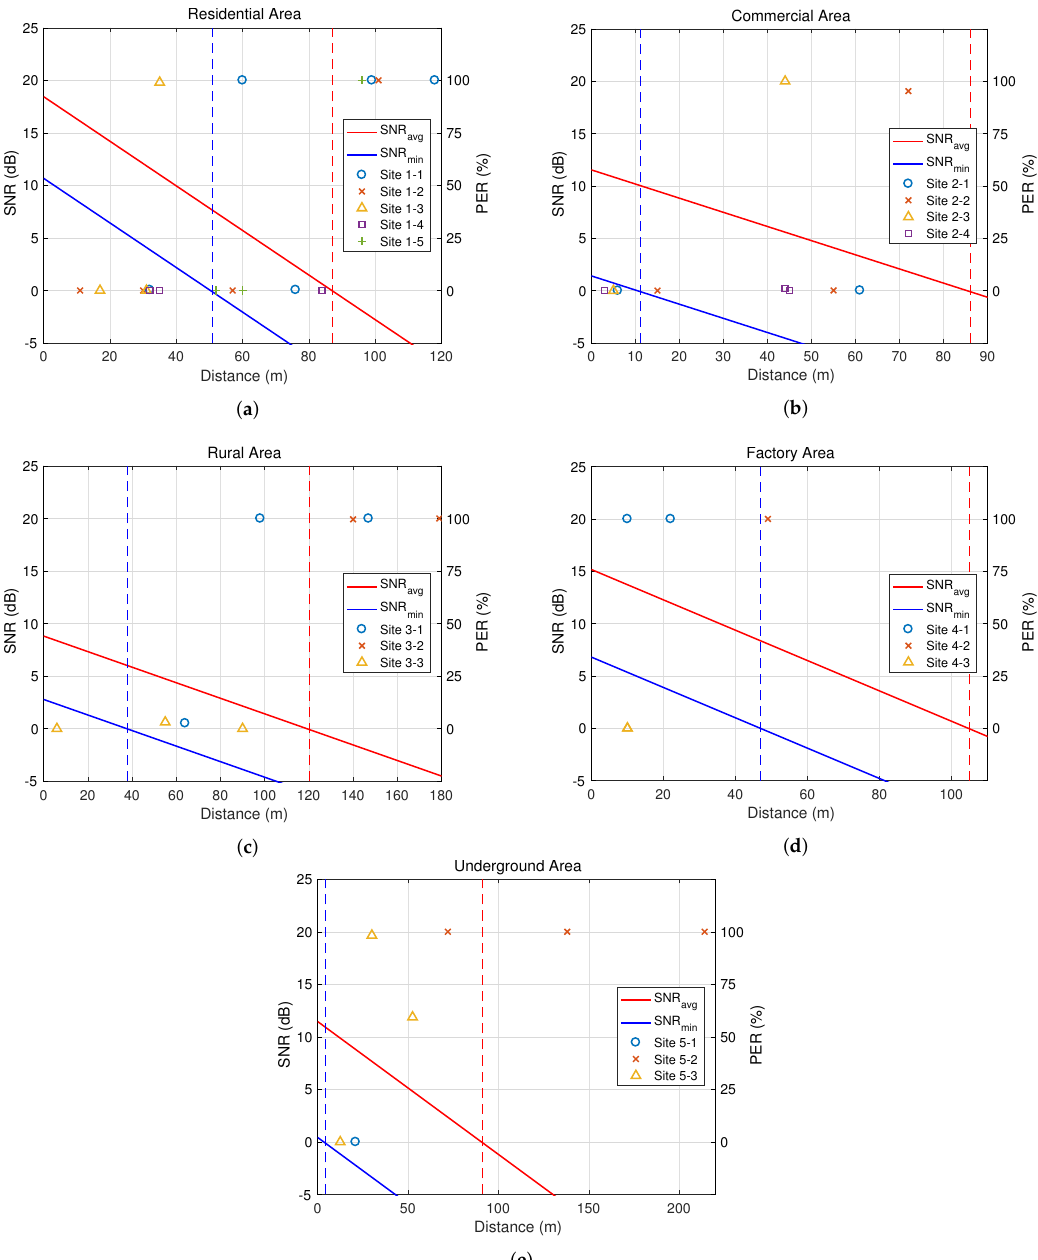
Figure 30. Signal-to-noise ratio (SNR) and PER with respect to the distance. ( a ) Overhead Residential Area. ( b ) Overhead Commercial Area. ( c ) Overhead Rural Area. ( d ) Overhead Factory Area. ( e ) Underground